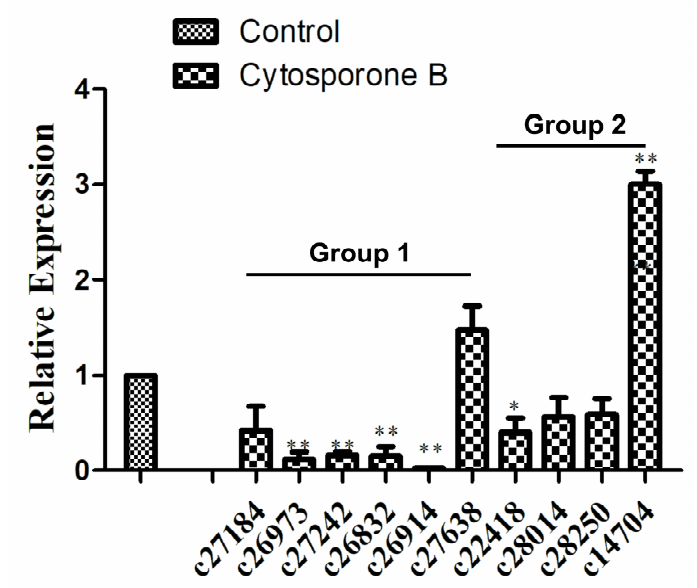
Figure 6. Relative expression levels of selected target genes of cytosporone B in G. citri-aurantii . Gene expression in control group was set as 1. Group 1 means the genes involved in amino acid synthesis and metabolism, and group 2 means the genes involved in signal transduction mechanisms. Each datum point represents a mean ± standard deviation (n = 3), and the values marked by the asterisks are significantly different (* p < 0.05; ** p < 0.01).